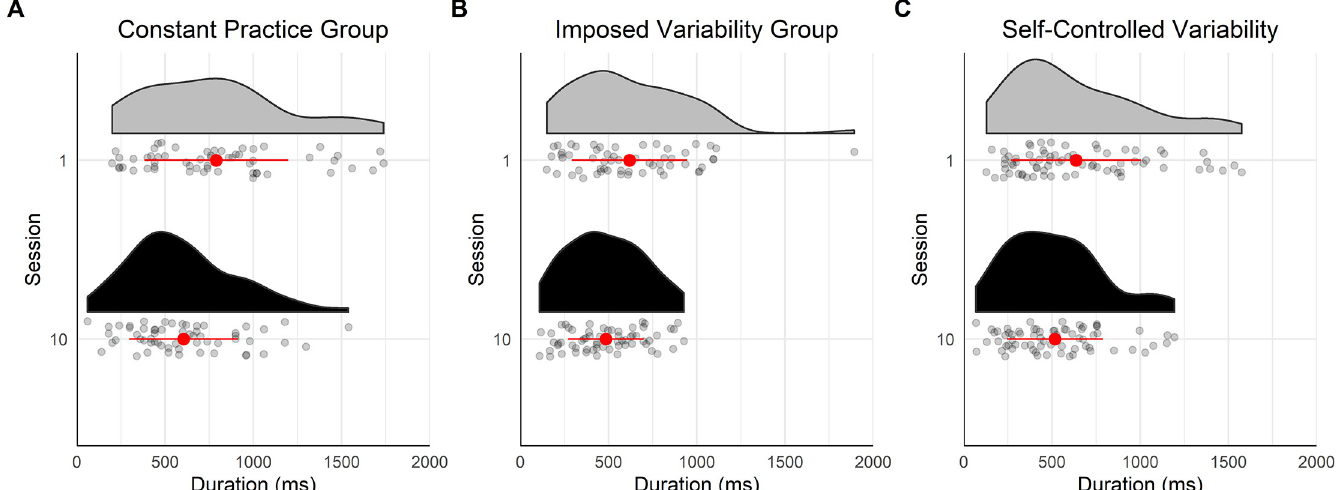
Fig 9. Duration of the last gaze visit before the hand contact the handhold for the three groups on the transfer route. In (A), (B) and (C), each point represents one gaze visit before a contact with a handhold, the halves violin shows the density of points, the red/grey point with the error bar refers to the mean of all the gaze visits and the standard deviation around the mean. The color of the half violin refers to the learning session: in grey, session 1 and in black, session 10. (A), (B) and (C) shows data for the constant practice group, imposed variability group and the self-controlled variability group respectively.